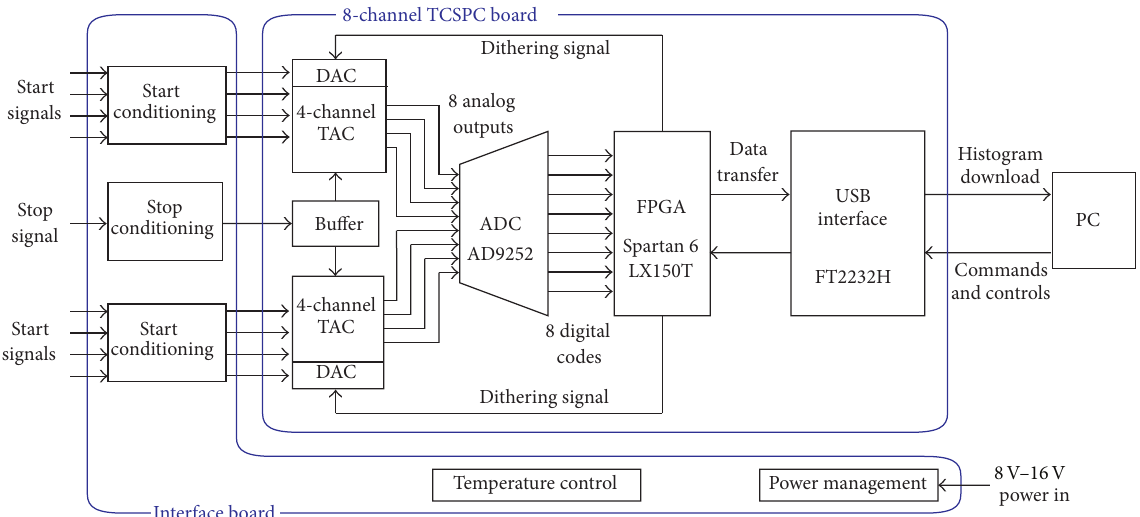
Figure 12: Block diagram of the 8-channel PoliMi TCSPC module (DAC: digital-to-analog converter, TAC: time-to-amplitude converter, ADC: analog-to-digital converter, FPGA: field-programmable gate array, USB: universal serial bus, and PC: personal